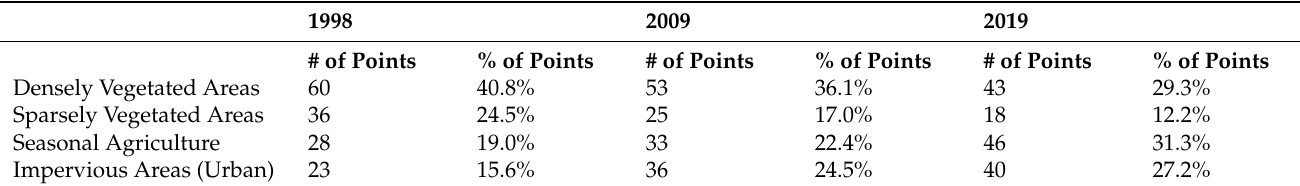
Table 1. Ground points represented by different land types for 1998, 2009, and